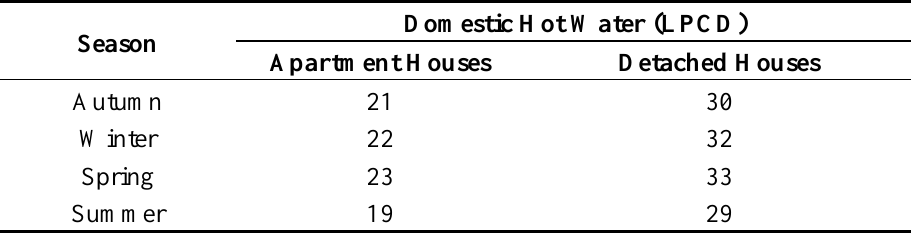
Table 9. Amount of DHW considered in the third